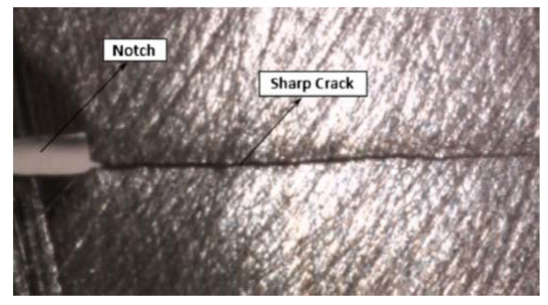
Figure 31. A typical image of a sharp crack [26].